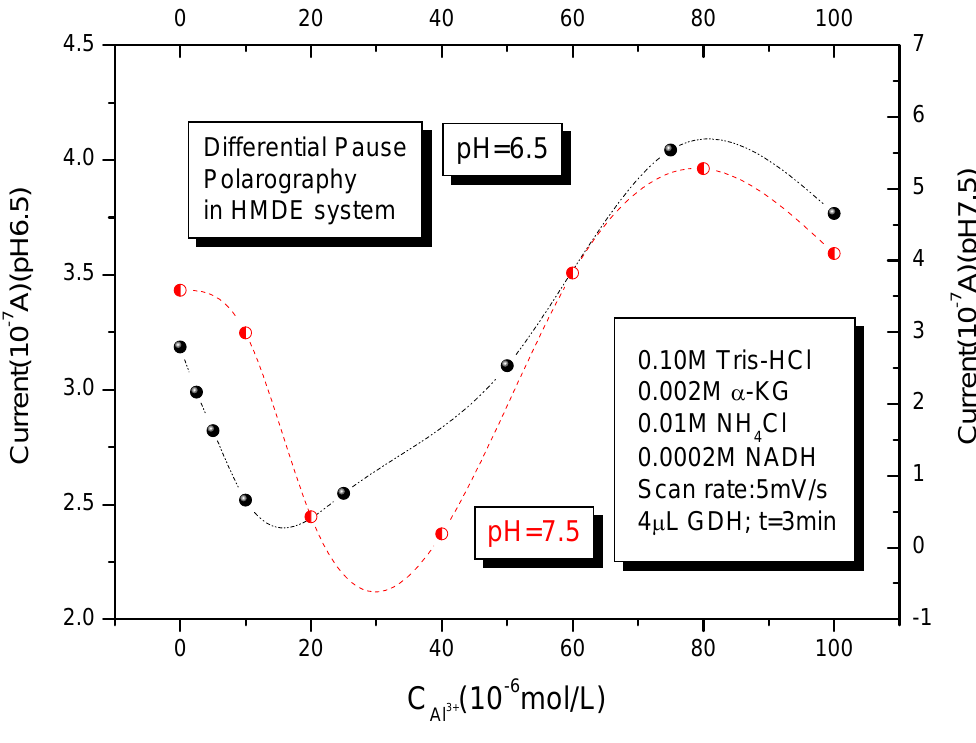
Figure 2. DPP peak currents as a function of Al (III) concentration; in 0.1M pH=6.5